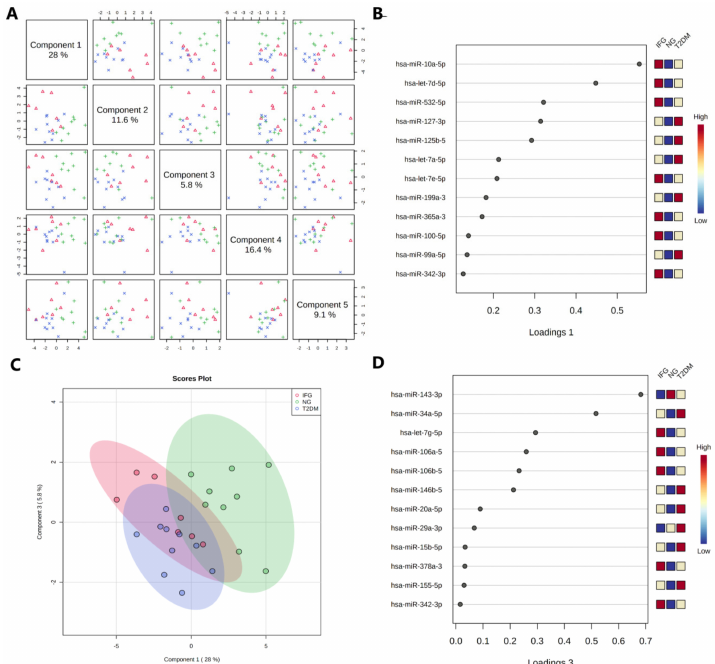
Figure 8. 5-component sPLS-DA with LOOCV validation method performed for T2DM, IFG, NG female study subjects (N = 26). ( A ) Pairwise score plots overview with explained variance for each component. ( B ) Loading plot presenting miRNAs selected by sPLS-DA model for component 1. miRNAs were ranked according to their absolute values ( C ) Scores plot between components 1 and 3 with 95% confidence region. ( D ) Loading plot presenting miRNAs selected by sPLD-DA model for component 3. miRNAs were ranked according to their absolute